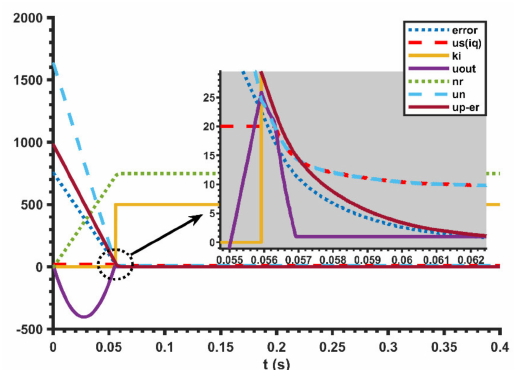
Figure 4. Comparison of the various outputs of the CVSPI